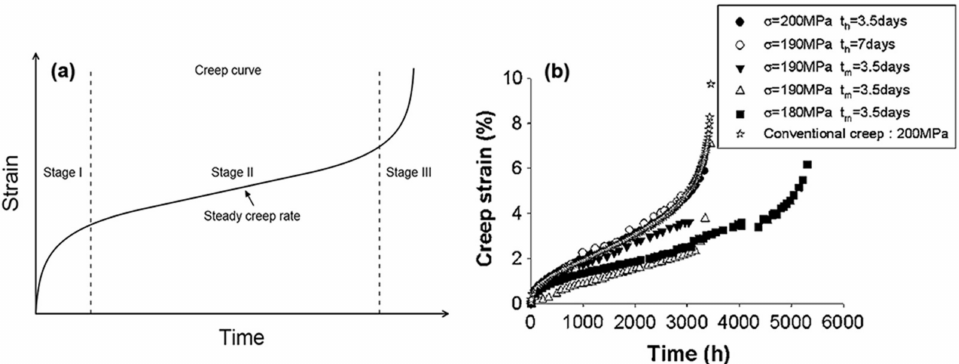
Figure 3. ( a ) Schematic illustration and ( b ) actual evolution of creep strain curve